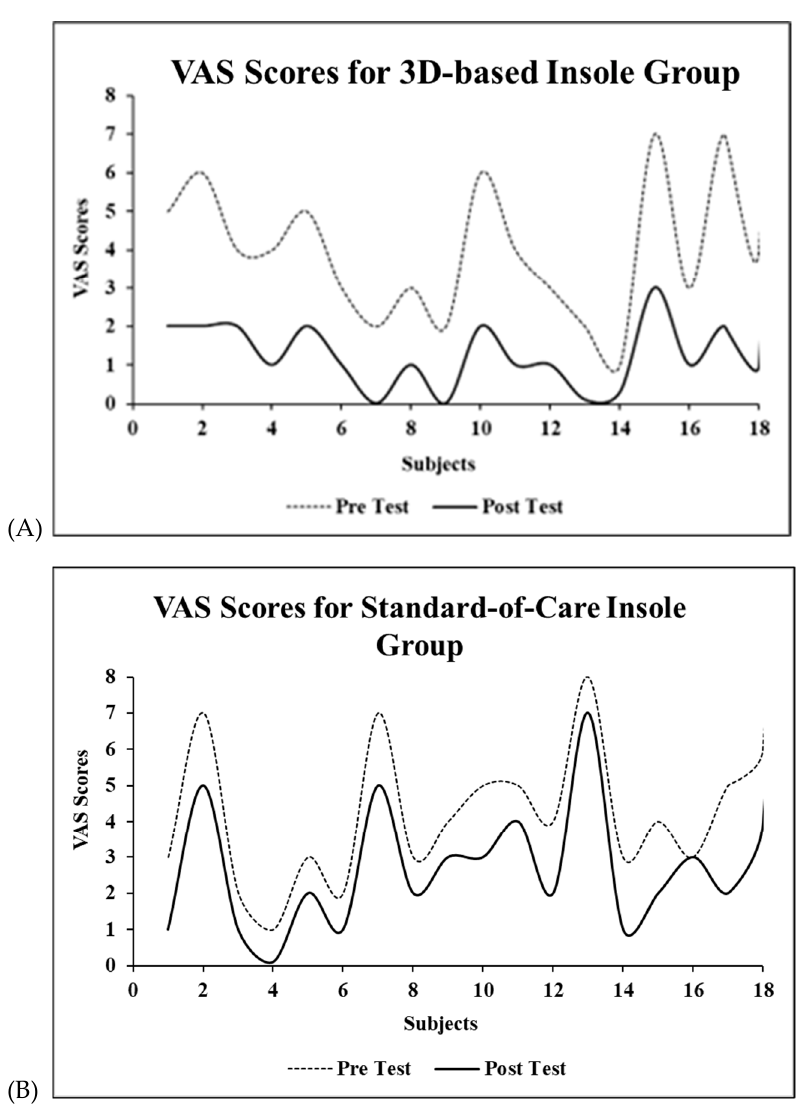
Figure 5. Pre-test and post-test values of VAS for pain in groups wearing ( A ) 3D printing-based customized and ( B ) standard-of-care